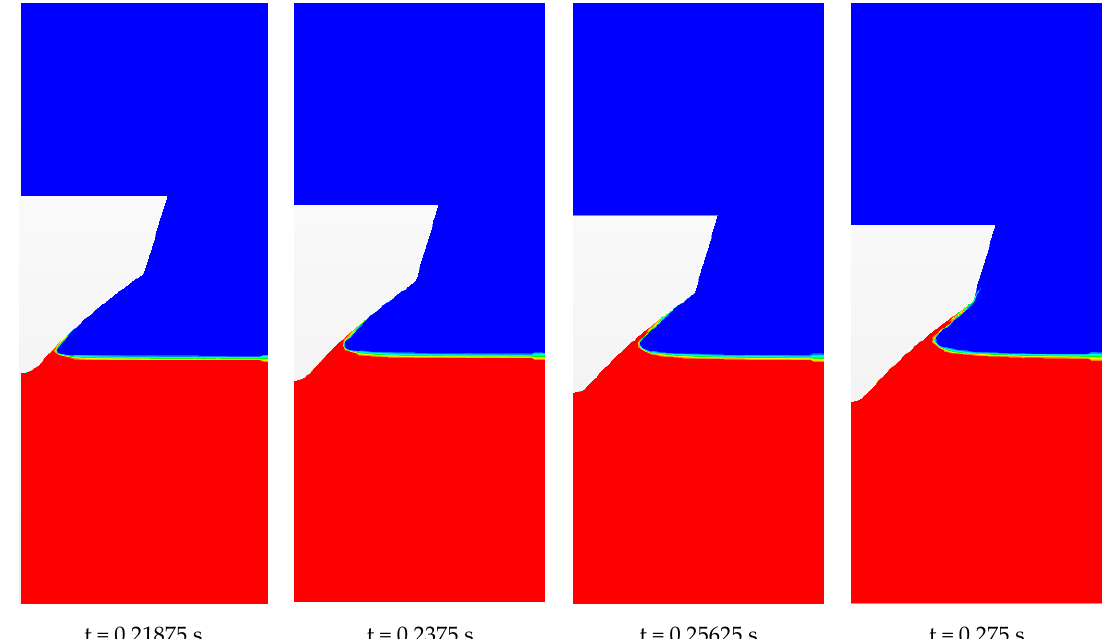
Figure 15. Free surface evolution during the water entry of the modified section “S4”.